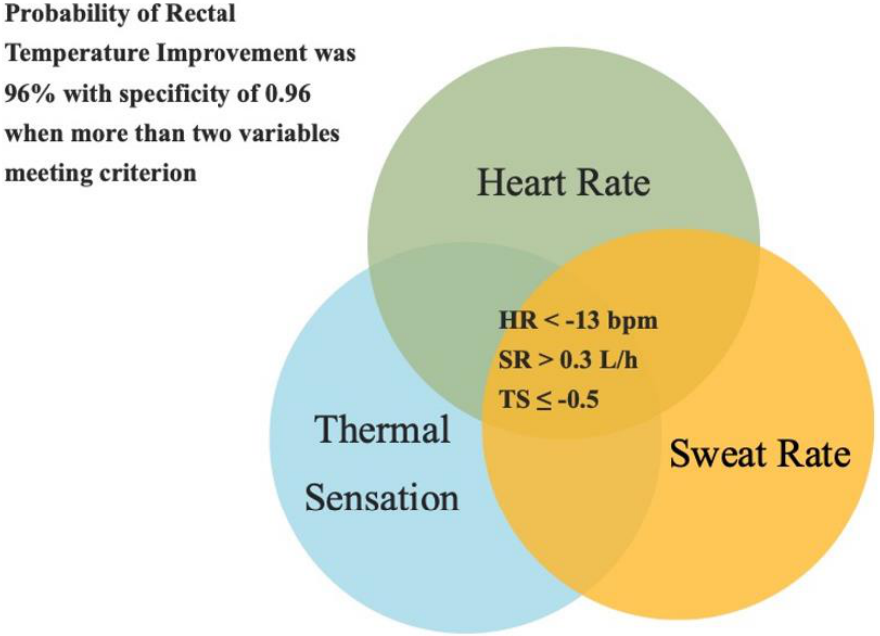
Figure 4. A Venn diagram consisting of heart rate, thermal sensation, and sweat rate to indicate if rectal temperature adaptation occurred or not. Cut-points were heat rate < − 13 bpm, sweat rate > 0.3 L · h − 1 , and thermal sensation ≤ − 0.5 between pre- and post-trials. When three or two variables met cut-points, the rectal temperature decreased in 96% of the cases.